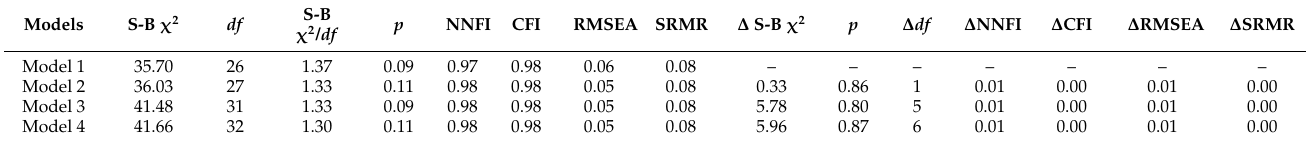
Table 2. Multiple-group analysis of WFGS: configural, metric, and residual